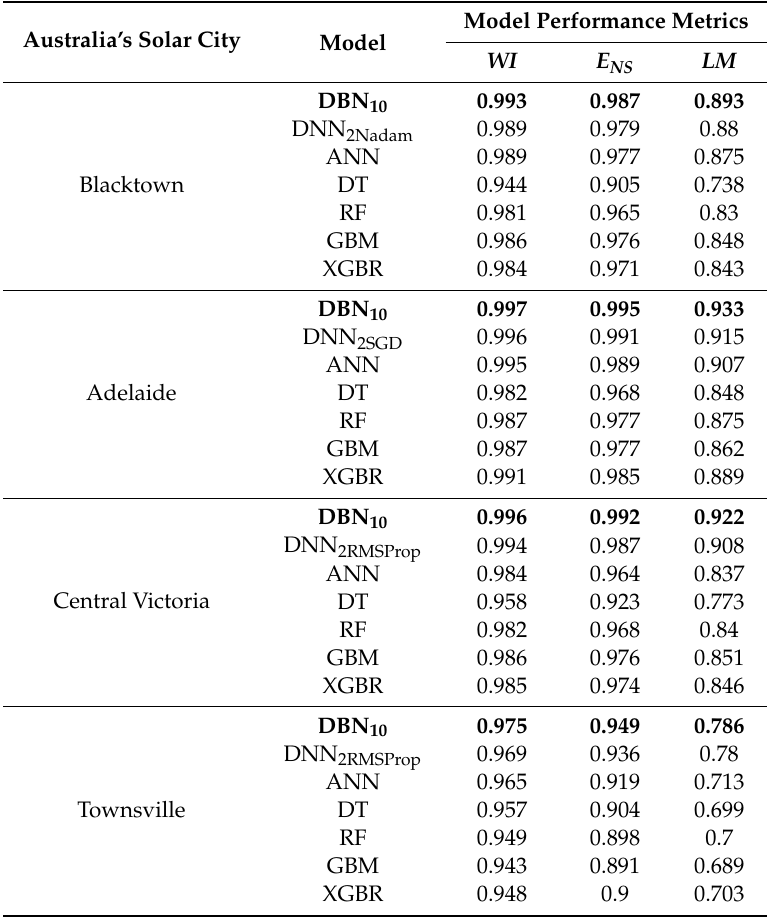
Table 8. Performance of deep learning models (i.e., DNN 10 , DBN 2Nadam ) with respect to their comparative counterpart models. The best model is highlighted in